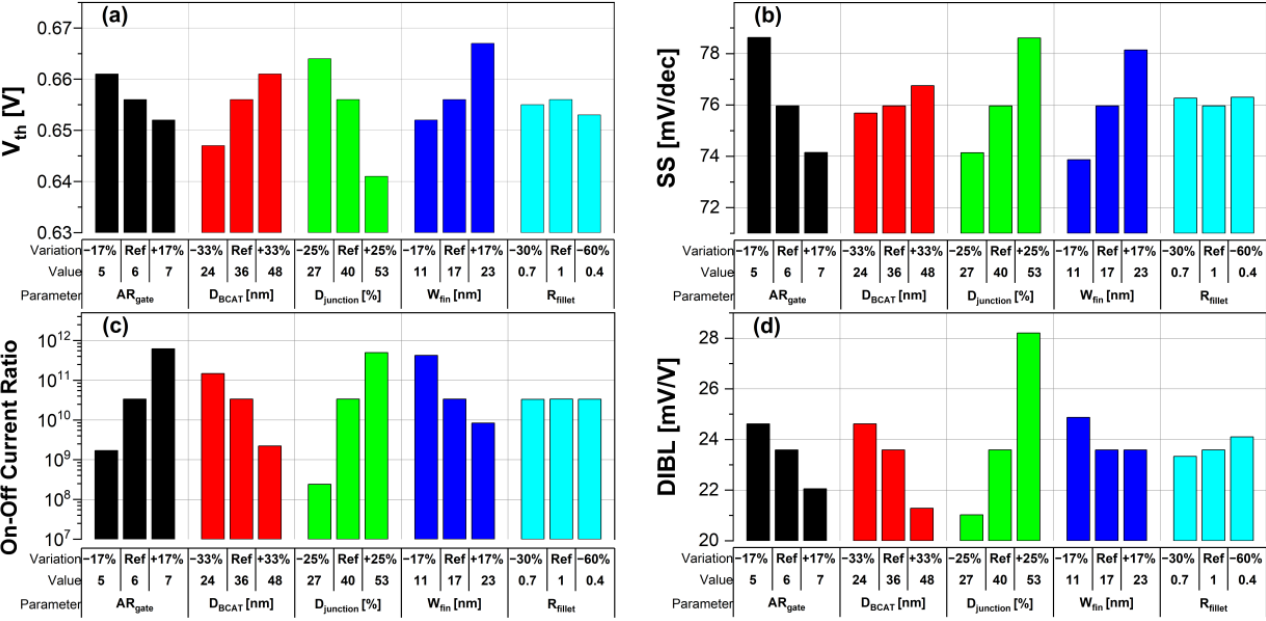
Figure 3. Performance metrics of BCAT: ( a ) threshold voltage (V th ), ( b ) subthreshold swing (SS), ( c ) on-/off-current ratio, and ( d ) drain-induced barrier lowering (DIBL) for given parametric variations. However, the purpose of the stacking nitride insulator layer on top of the metal gate is to reduce gate-induced drain leakage (GIDL) by isolating the metal gate and drain and